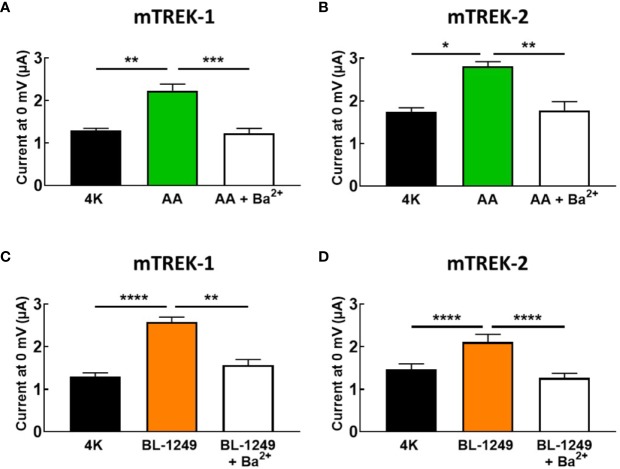
Ba2+ blocks AA and BL-1249 activated of mTREK-1 and mTREK-2 channels. Bar graphs displaying the effects of barium ion (Ba2+) block of (A) AA-activated mTREK-1, (B) AA-activated mTREK-2, (C) BL-1249 activated mTREK-1, and (D) BL-1249 activated mTREK-2 channel currents. mTREK-1 and mTREK-2 channel currents were recorded from Xenopus laevis oocytes by TEVC. (A, C) Mean currents for mTREK-1 at 0 mV showing the effects of 1 mM Ba2+ after pre-activation by 10 μM AA (A, n = 8) or 1 μM BL-1249 (C, n = 10). (B, D) Mean currents for mTREK-2 at 0 mV showing the effects of 1 mM Ba2+ after pre-activation with 10 μM AA (B, n = 6) or 3 μM BL-1249 (D, n = 9) activation. Data are presented as mean ± SEM. *p < 0.05, **p <0.01, ***p < 0.001, ****P < 0.0001, Student's paired t-test.